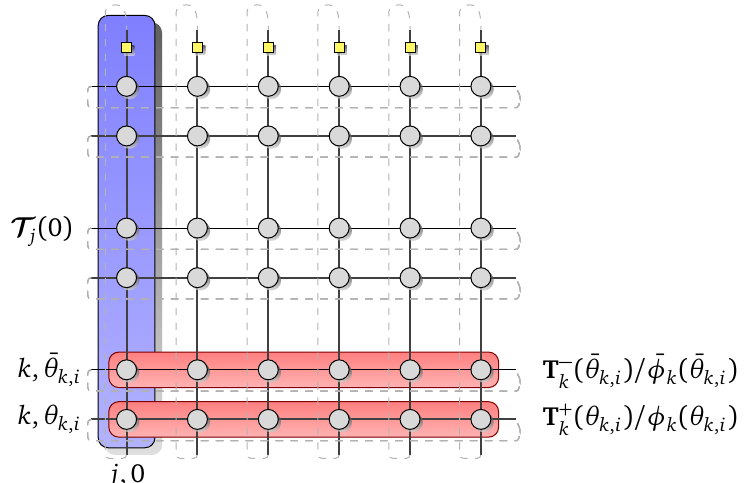
Figure 3: The equilibrium partition function is computed by wrapping the cylinder of Figure 2 to a torus, i.e. tracing over the physical sites. This can be viewed as an inhomogeneous iteration of the homogeneous row transfer matrices T ± physical system as in Eq. (6.1). Alternatively it can be expressed as a homogeneous iteration of the inhomogeneous column transfer matrices T system. The latter admits a dominant eigenvalue as given in Eq. (6.3). the combination of the auxiliary spaces: H